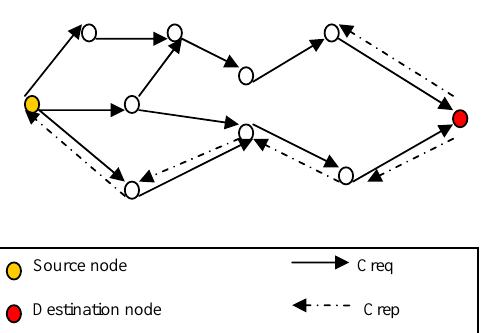
Figure 3: the diagram for distributed scheme The generation of a secret share for a new node that joins the network is constructed by a coalition SK, of t nodes currently in the network. When a new node wants to join to the network, a new node broadcasts an initialization request to the neighbors nodes and when the all coalition receive this request they generate the = s G (mod n) which is encrypted by parameter p 1 i  1 i  the public key of the new node. Also they compute